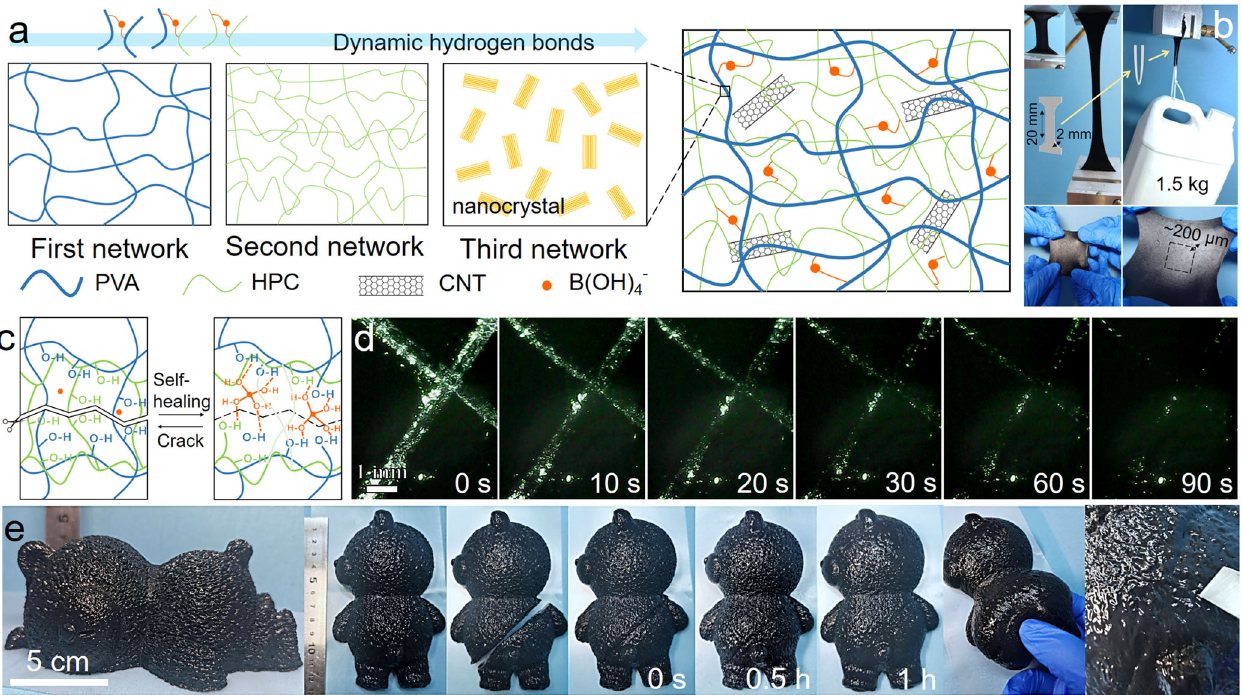
Fig. 2 Mechanical strength and self-healing properties of PVA-S hydrogel. a Schematic mechanism representation of PVA-S hydrogel ’ s ternary strength elements. b Outstanding mechanical strength of the PVA-S hydrogel: stretching, lifting test with a load of 1.5 kg and in-plane extension. c Schematic illustration of the self-healing mechanism of PVA-S hydrogel. d Optical microscopy images of the X-shaped scratch on the PVA-S hydrogel before and after healing for 90 s at room temperature. e Massive bear-shaped PVA-S hydrogel ( ≈ 15 cm × 8 cm × 5 cm) was cut in half, replaced, and healed adequately for 1 h at room